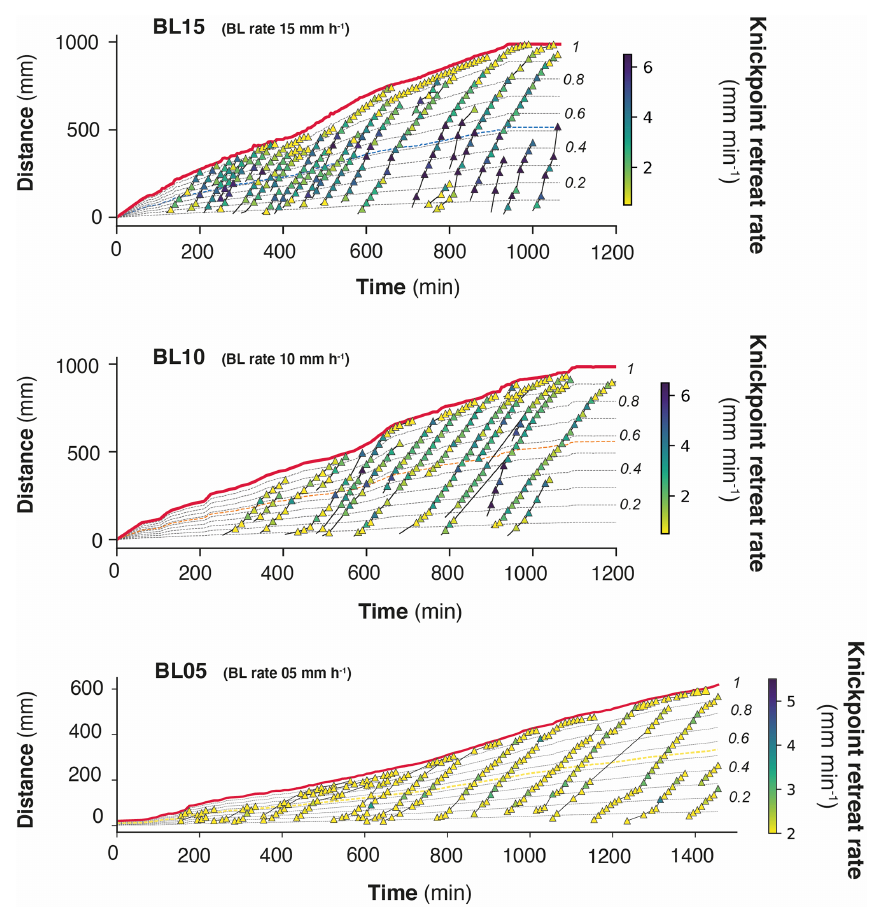
Figure 8. Space–time diagrams showing the propagation of the water divide (red line) and successive trajectories of knickpoints (triangles). Symbol color shows instant (10min) knickpoint retreat rate. Thin dashed black lines show the normalized distances to divide (nDD). Thin dashed colored lines show nDD V , the normalized distance where the highest rate of retreat velocity is deduced from the analysis (see text max and Fig. 9c). Note the change in scale and color bar for experiment